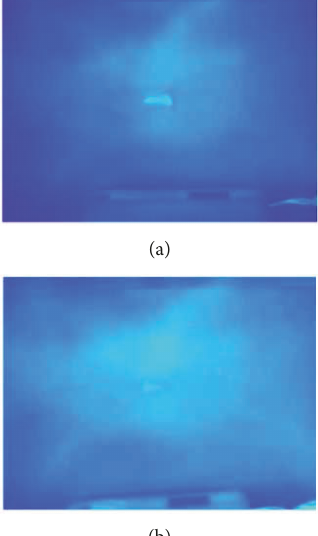
Figure 10: Thermographs of samples SC1 (a) and SC3 (b) during heating.